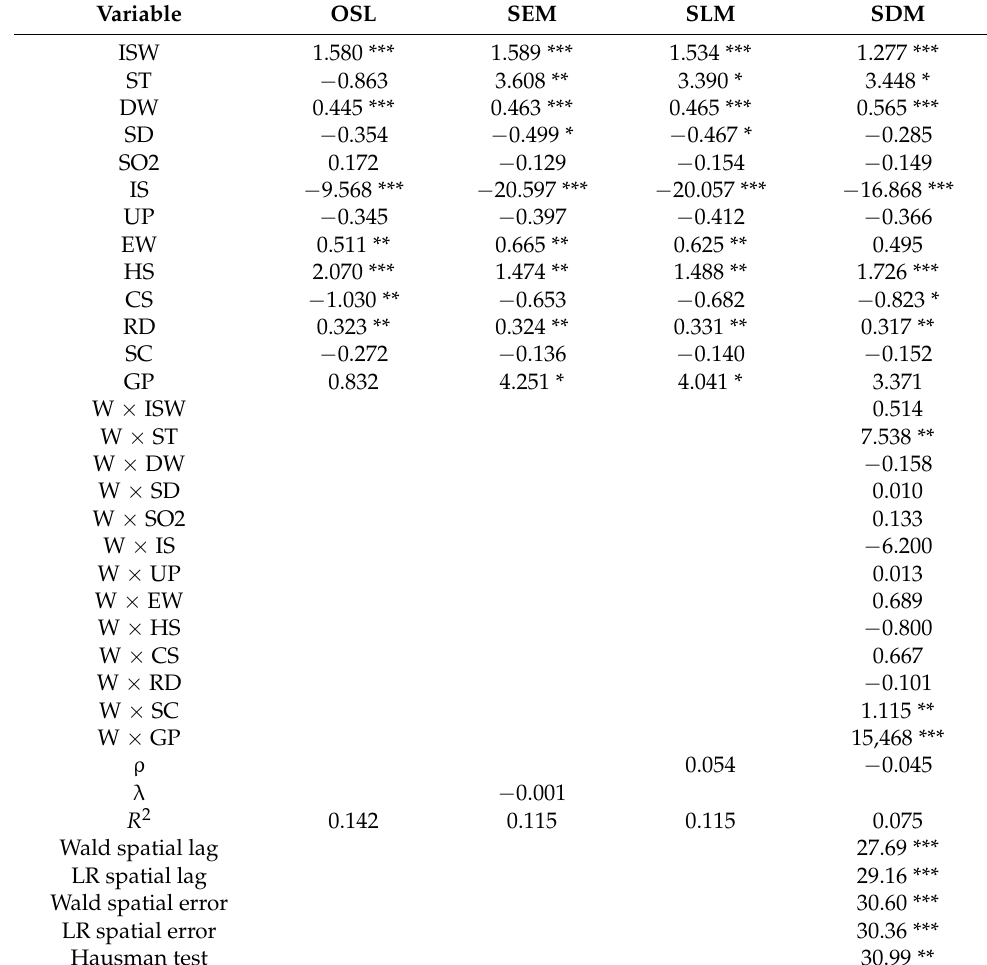
Table 6. Regression results of the internal structure of the impact of GTI on